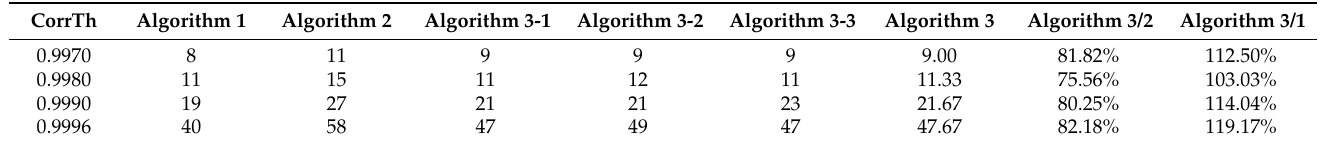
Table 3. The number of the selected bands of the three algorithms under four selected correlation coefficient